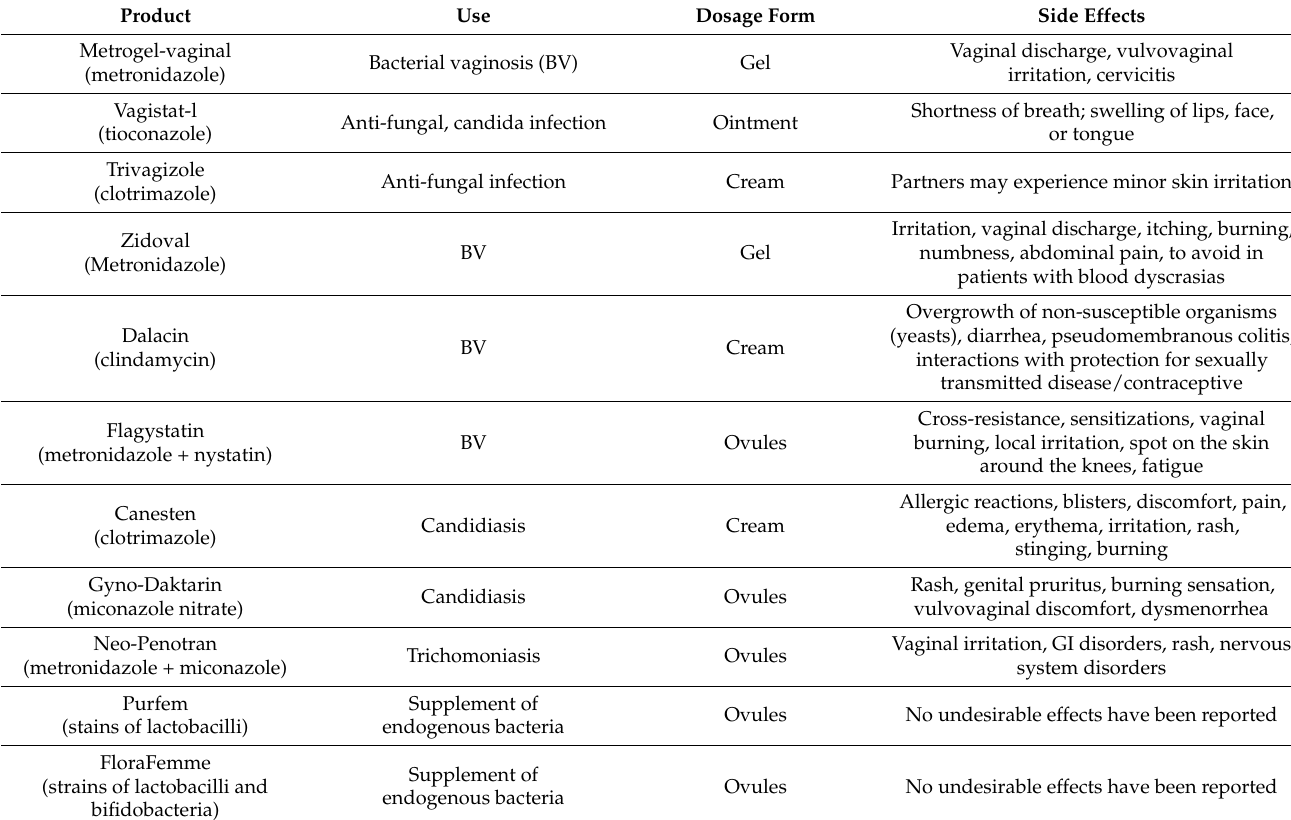
Table 2. Some examples of commercial vaginal products for local drug delivery